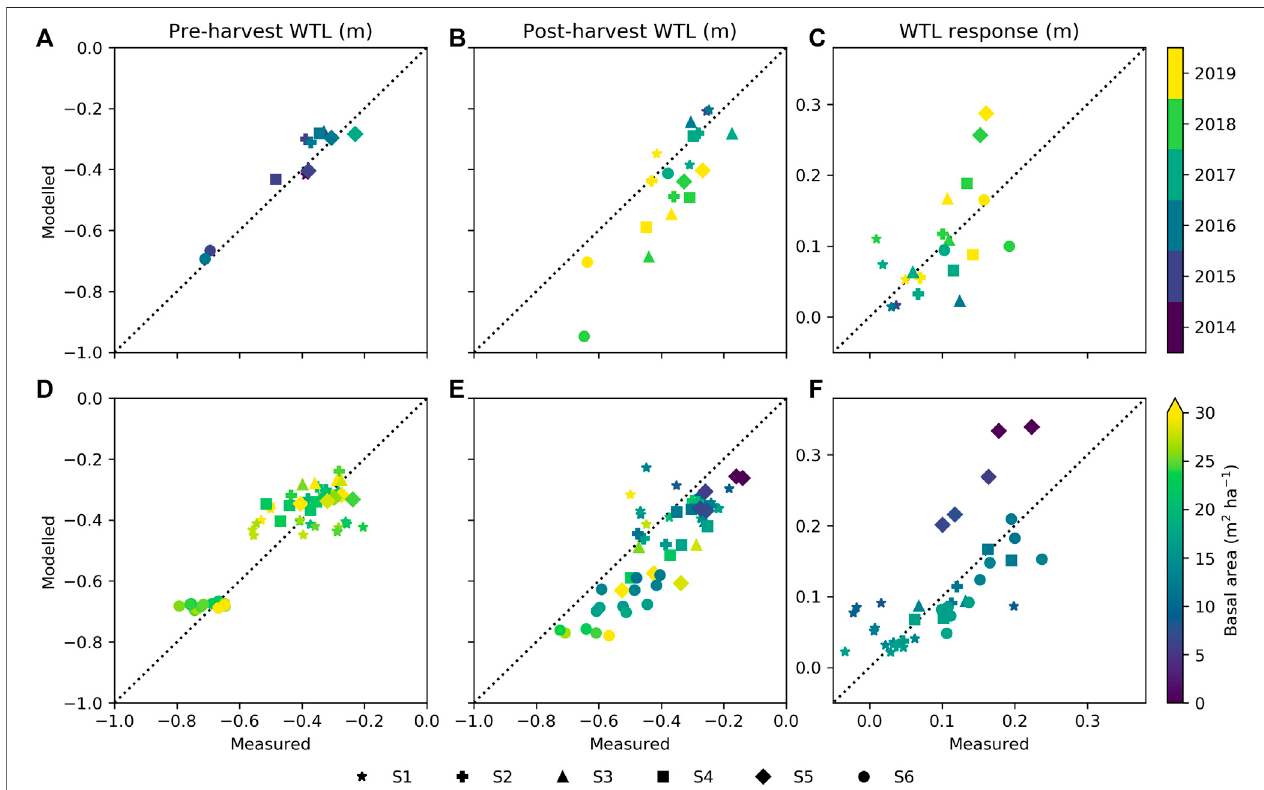
FIGURE 6 | Modeled against measured water table level (WTL) for pre- and postharvest periods and WTL response to harvesting as (A – C) yearly site mean, and (D – F) plot mean with colors showing stand basal area and symbols indicating study sites. Data from period June to October are included.